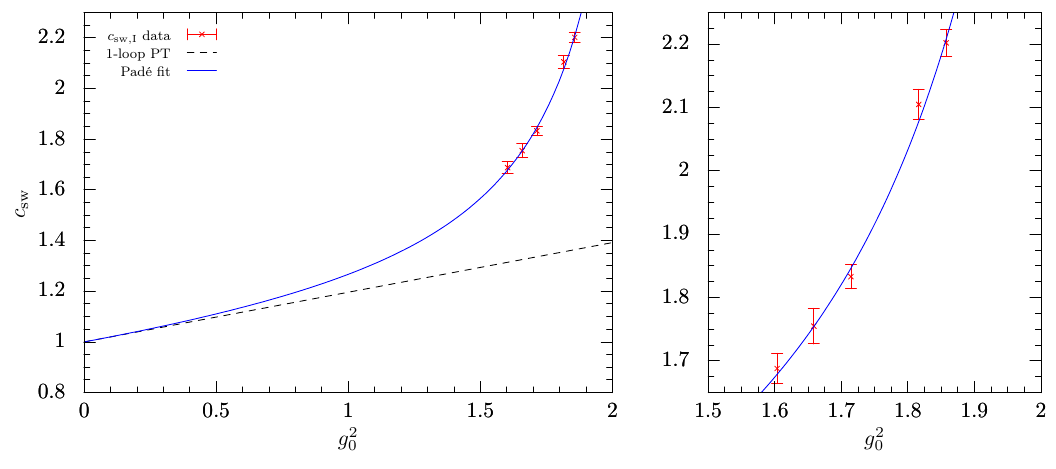
2 , cf. eq. (5.9), along 0